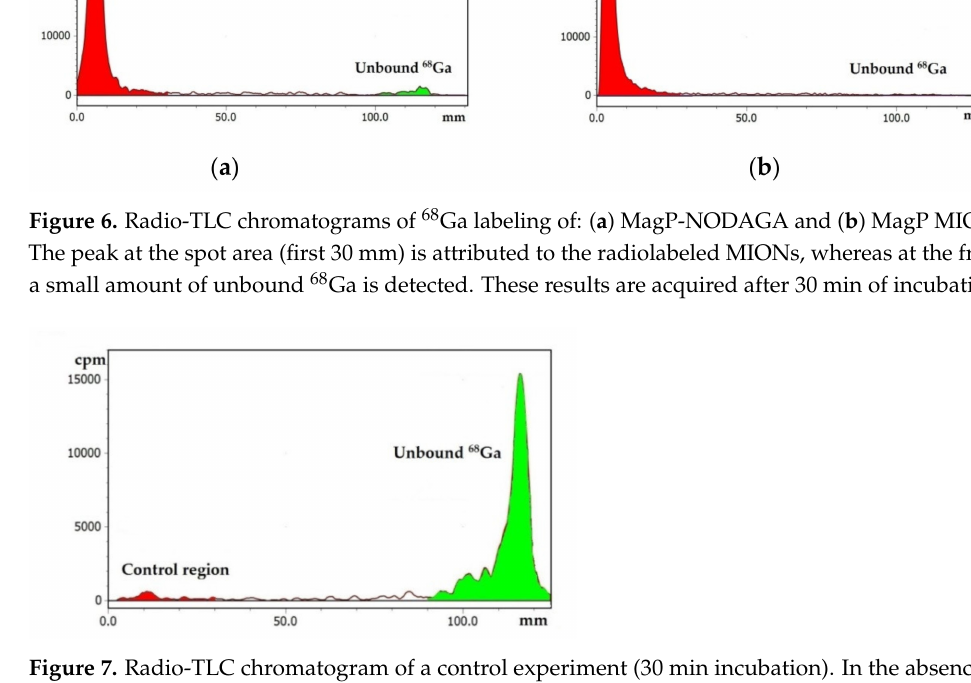
Figure 7. Radio-TLC chromatogram of a control experiment (30 min incubation). In the absence of nanoparticles, free 68 Ga ions move to the front; thus, the highest amount of radioactivity is detected in this